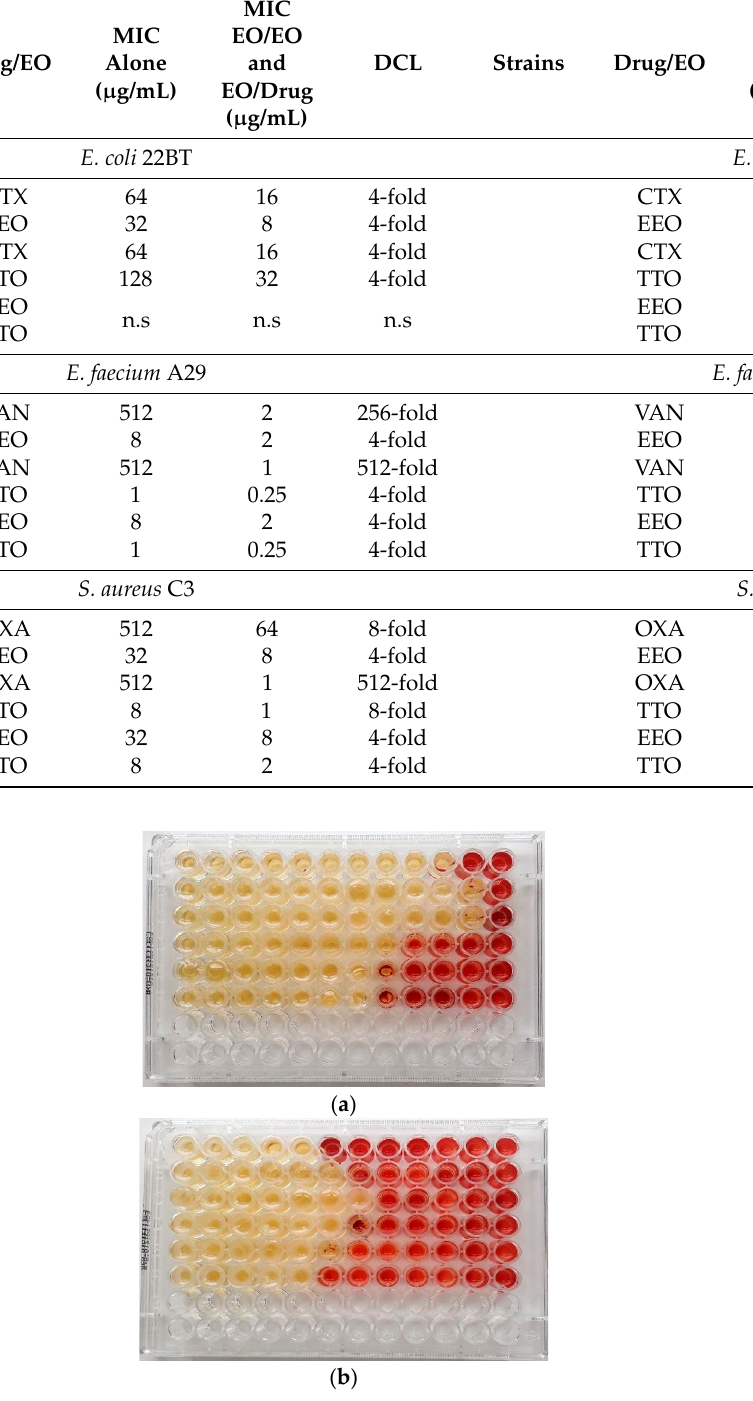
Figure 1. MIC ( μ g/mL) of ( a ) Malaleuca alternifolia Chell. (TTO) and ( b ) Eucalyptus globulus Labill. (EEO) EOs determined by the broth microdilution method with addition of 2,3,5-triphenyltetrazo- lium chloride (TTC) at concentrations of 0.5% against ARB pathogens in planktonic form. Serial dilutions of EOs were added to each well to obtain concentrations ranging from 512 to 0.25 μ g/mL (from left to wright). Line 1: Escherichia coli 22BT; Line 2: Escherichia coli 45DT; Line 3: Enterococcus faecium A29; Line 4: Enterococcus faecalis VAN3; Line 5: Staphylococcus aureus C3; Line 6: Staphylococ- cus aureus O.